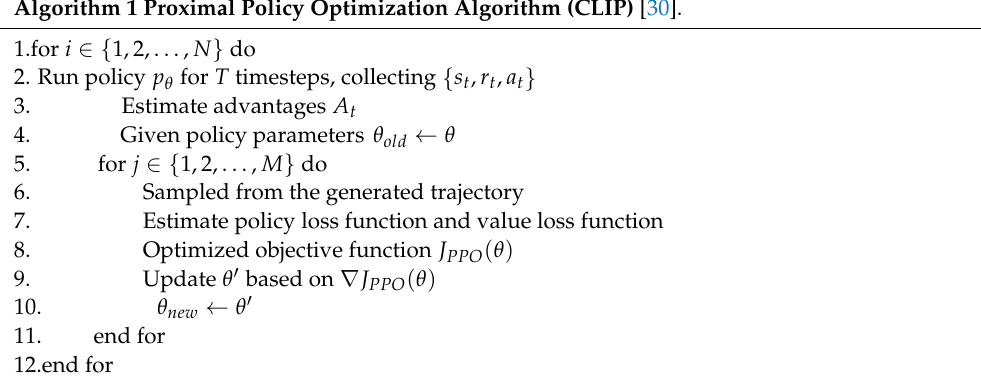
Algorithm 1 Proximal Policy Optimization Algorithm (CLIP)